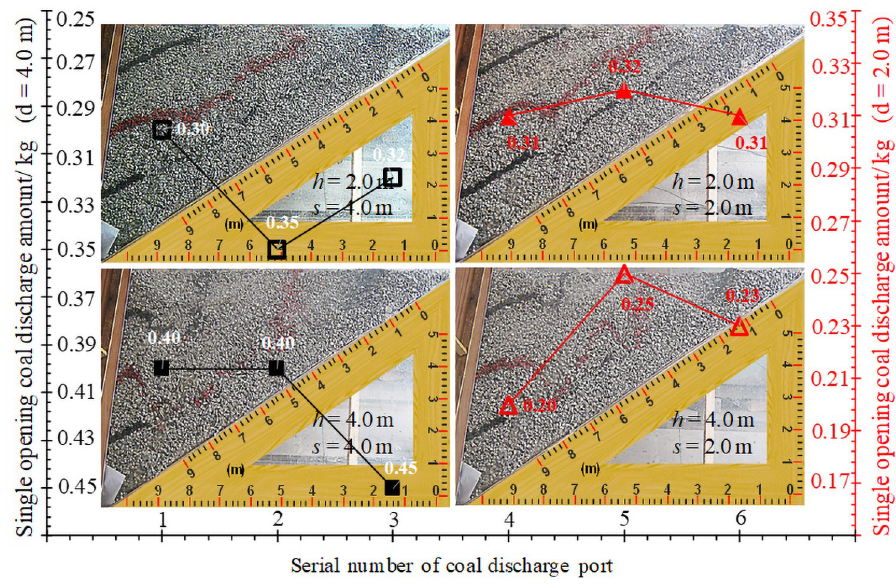
Fig 13. Release form and coal release amount of